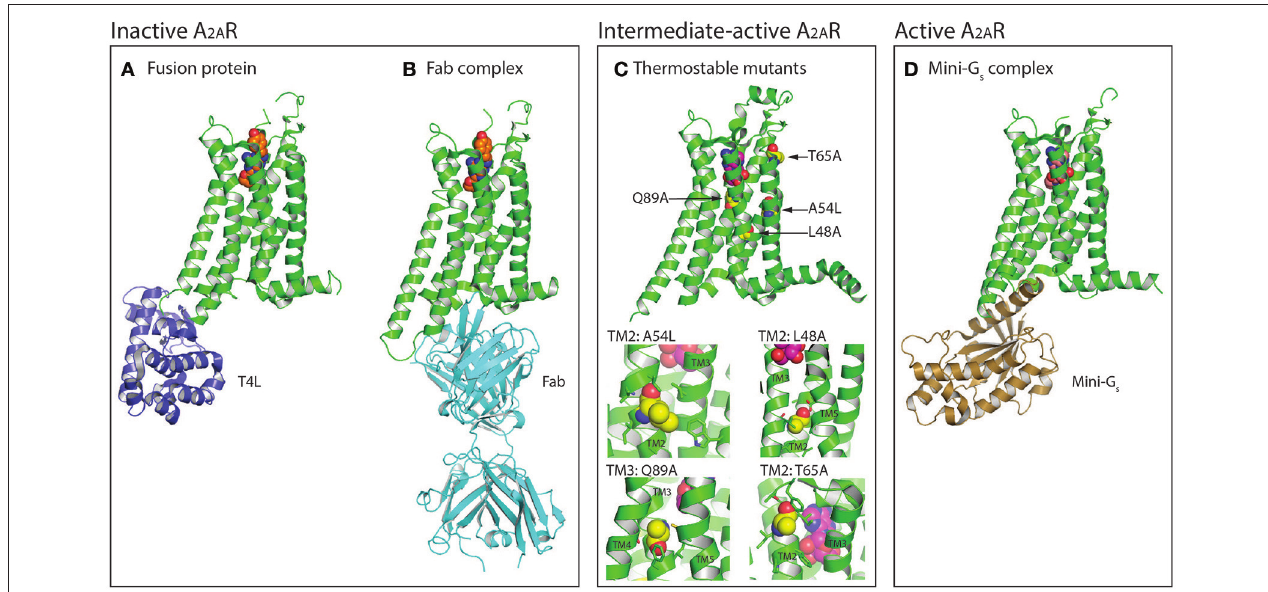
FIGURE 1 | Protein engineering strategies used for the selection and crystallization of distinct A 2A R conformations. (A) Crystal structure of A 2A R (colored green) in the inactive conformation bound to the inverse agonist ZM241385 (shown as spheres, carbon atoms colored orange) with T4 lysozyme (T4L; colored blue) fused between the intracellular ends of H5 and H6 (PDB: 3EML) (Jaakola et al., 2008). The T4L fusion protein has also been substituted with apocytochrome b 562 RIL (BRIL; not shown) ( Liu et al., 2012). (B) Structure of A 2A R in the inactive conformation bound to ZM241385 (shown as spheres, carbon atoms colored orange) and an antibody F ab fragment (colored cyan) that acts as an intracellular inverse agonist (PDB: 3VG9 and 3VGA) (Hino et al., 2012). (C) Crystal structure of thermostabilized A 2A R-GL26 in the intermediate-active conformation bound to the agonist adenosine (shown as spheres, carbon atoms colored magenta), the four thermostabilizing mutations (L48A 2.46 , A54L 2.52 , T65A 2.63 , and Q89A 3.37 ) are shown as spheres and their carbon atoms colored yellow (PDB: 2YDO) (Lebon et al., 2011b). In the expanded view the residues with which the thermostabilizing mutations interact (distance < 4 Å) are shown as sticks. Conformational thermostabilization has facilitated the crystallization of A 2A R in both the agonist- and antagonist- bound conformations. (D) Structure of A 2A R in the active conformation bound to NECA (shown as spheres, carbon atoms colored light pink) and an engineered G protein mini-G s (colored brown; PDB: 5G53) ( Carpenter et al., 2016). Figures were prepared using PyMOL (PyMOL TM Molecular Graphics System, Version 1.8.6.0).